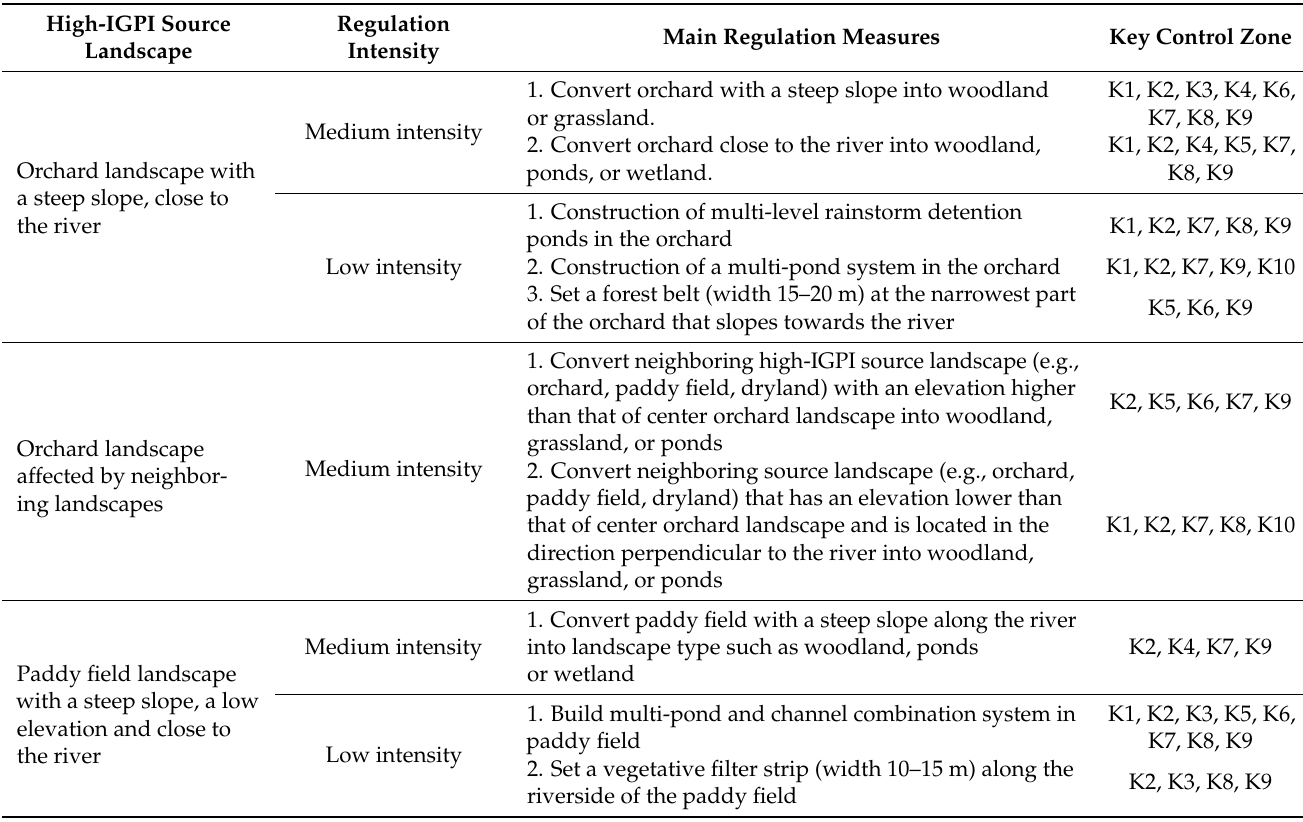
Table 4. The regulation strategies adopted by the 10 key control zones of the CSAs in the Jiulong River watershed. High-IGPI Source Regulation Main Regulation Measures Key Control Intensity